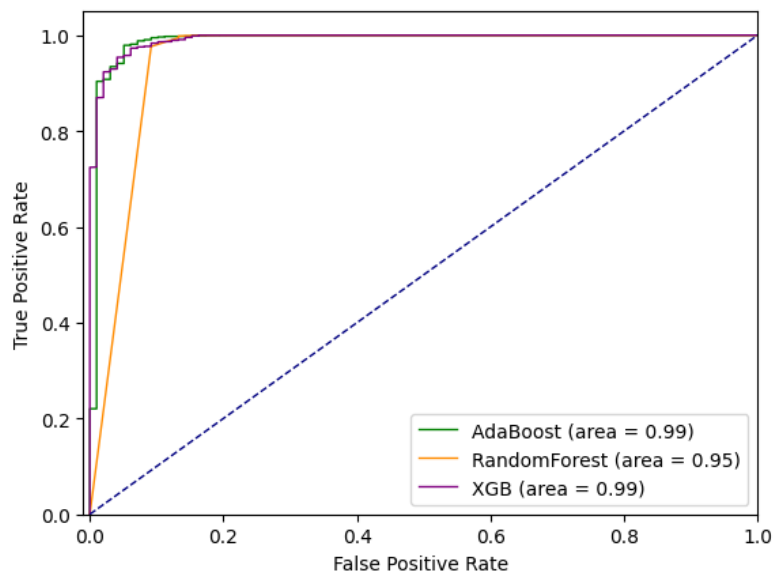
Figure 3. Extended CreditCard dataset—comparative ROC curve for ensemble methods.